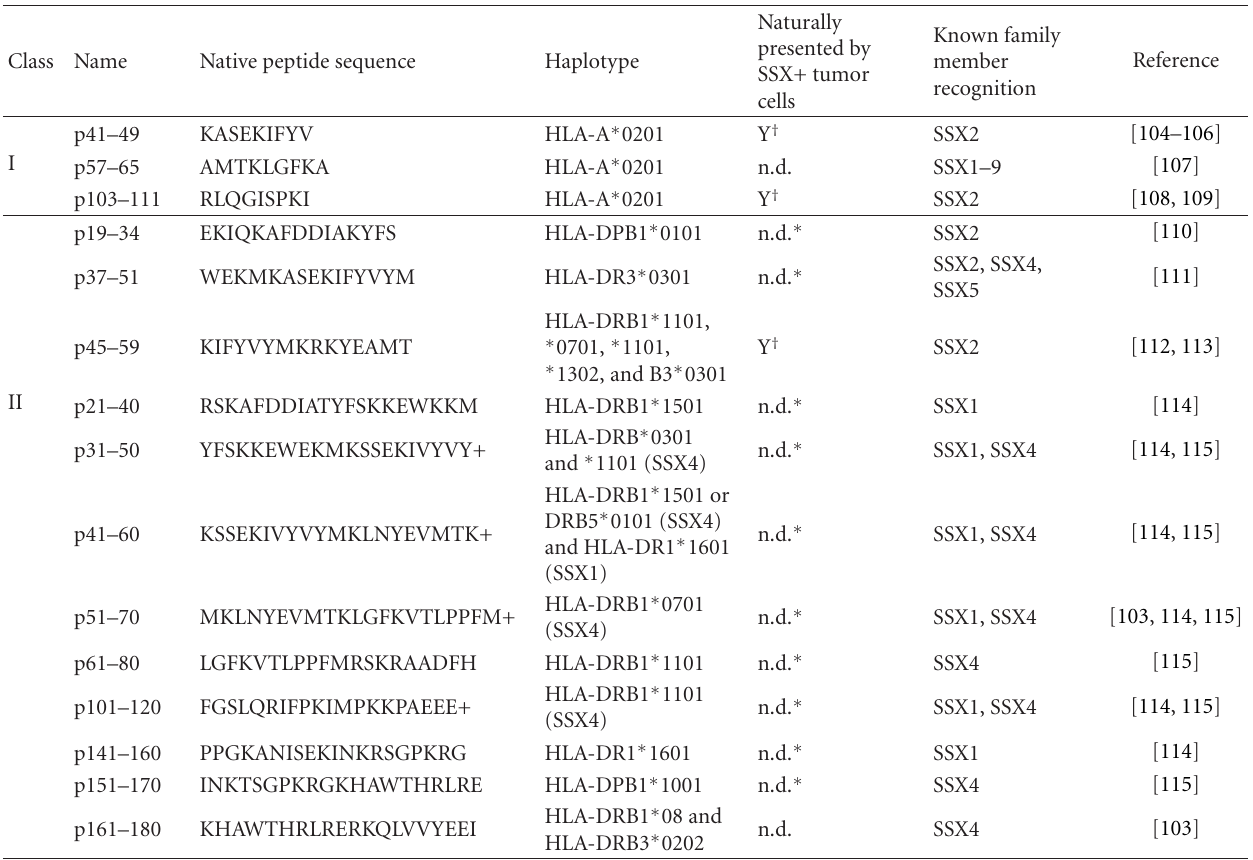
Table 3: SSX epitopes: sequences, haplotype restrictions, and recognition. The known SSX immunogenic class I and class II MHC peptides or epitopes are shown. Amino acid sequence, haplotype restriction, tumor presentation, family member recognition, and references are outlined for each peptide/epitope. Symbol designations include + = SSX4 sequence, n.d. = not demonstrated. † = p41–49 epitope shown to be recognized on Me 275, SK-MEL-37, T343B, and T567A melanoma cells and SW 872 liposarcoma cells; p103–111 shown to be recognized on SK-MEL-37 melanoma cells and LNCaP prostate cancer cells; and p45–59 shown to be recognized on Me 275 cells. ∗ = Recognized on antigen-loaded dendritic cells but not endogenously presented by tumor